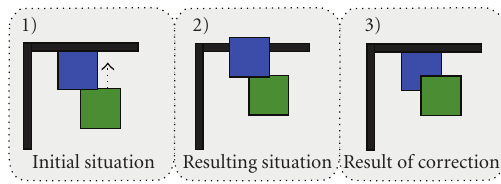
Figure 8: Externally caused wall